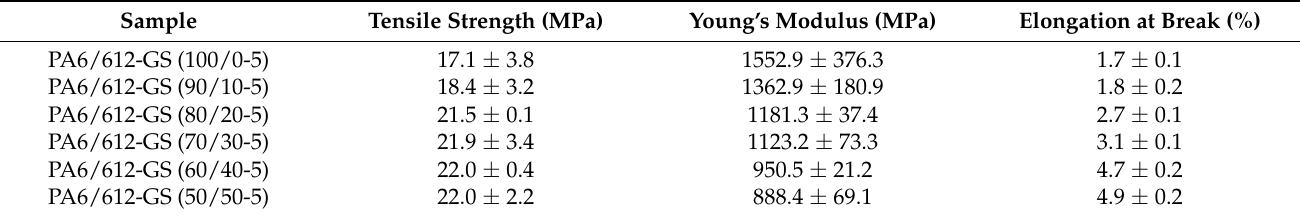
Table 1. Data on typical mechanical properties of PA6/612-GS